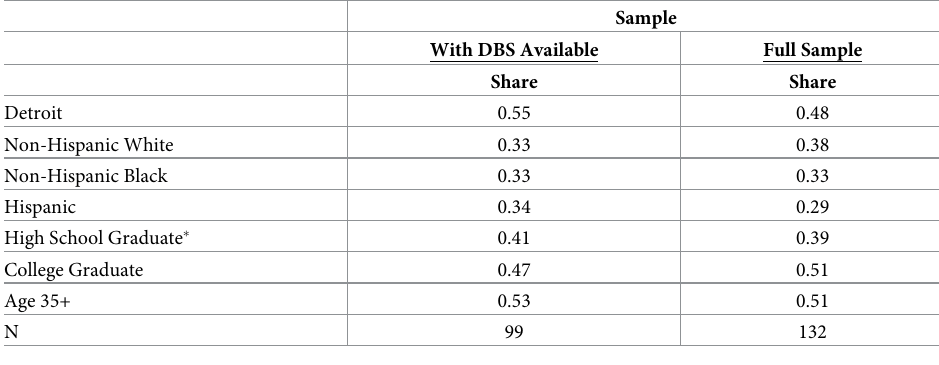
Table 3. Comparing samples with and without DBS